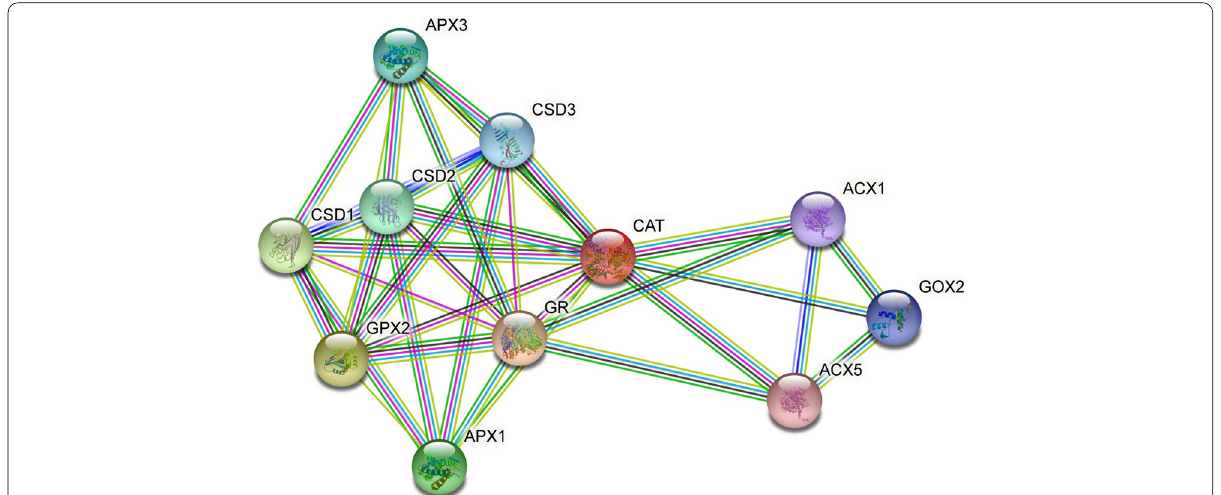
Fig. 7 Map of the protein-protein interaction of Arabidopsis thaliana catalase protein